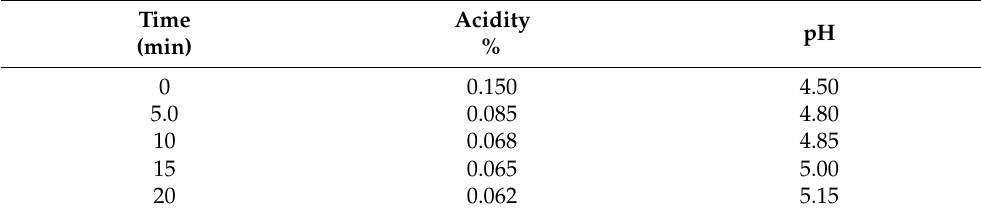
Figure 6. Lightness, redness and yellowness values of turnip samples after different processing steps. Different letters indicate a significant difference ( p < 0.05). Table 3. Typical changes in acidity and pH of radish samples during